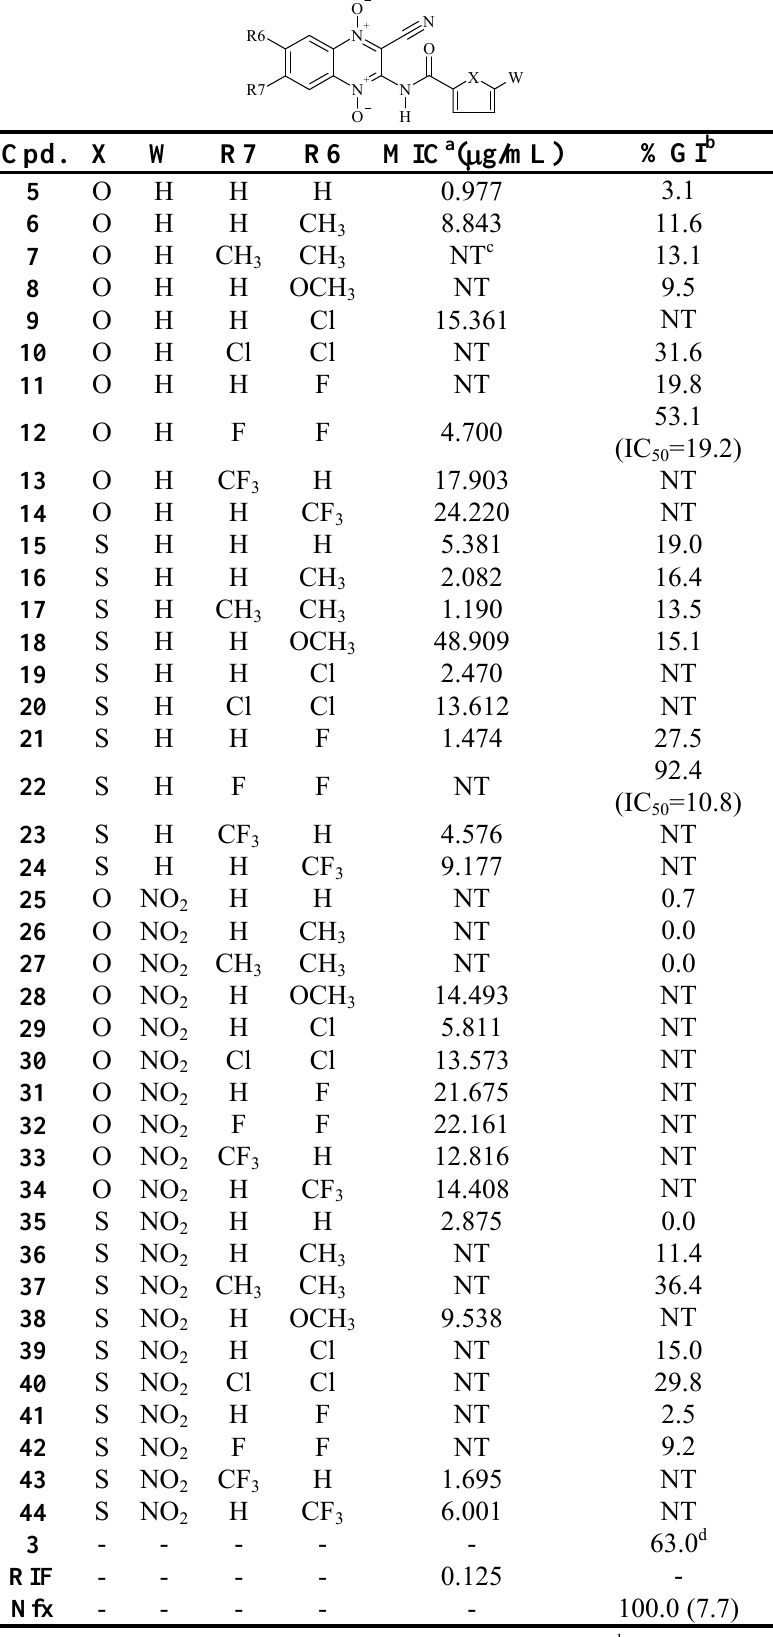
Table 1. Biological characterization of the forty new quinoxaline 1,4-di- N -oxides.